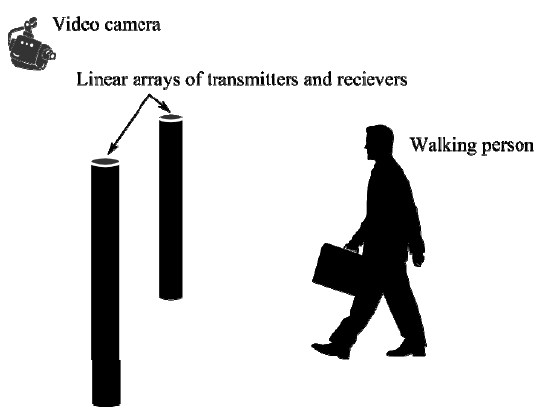
Figure 36. Schematic system for inverse aperture synthesis using radar and a video camera.